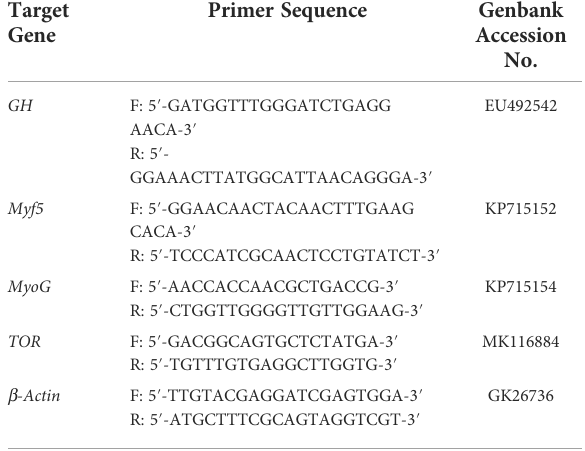
TABLE 2 Primers used for real-time